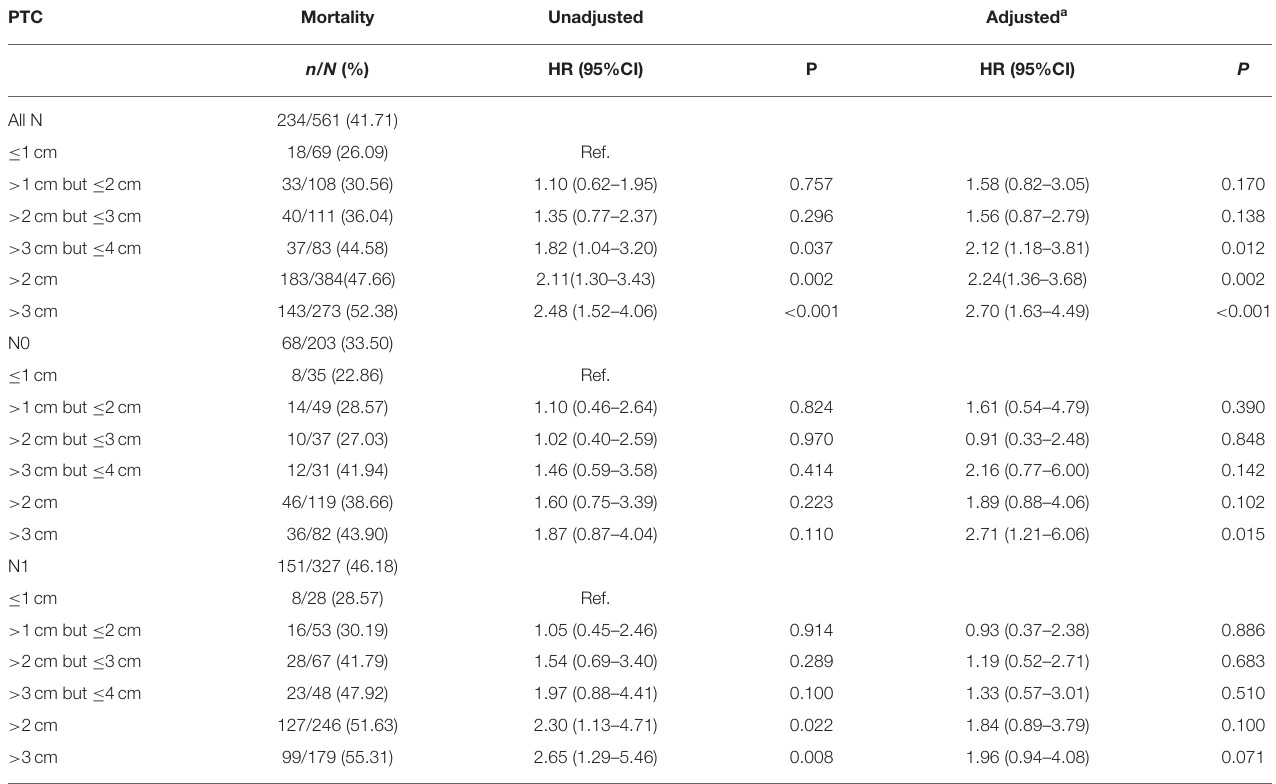
TABLE 3 | Further investigation on the association between tumor size and thyroid cancer specific mortality in papillary thyroid cancer patients with different N category (SEER database years of 2004–2016). PTC Mortality